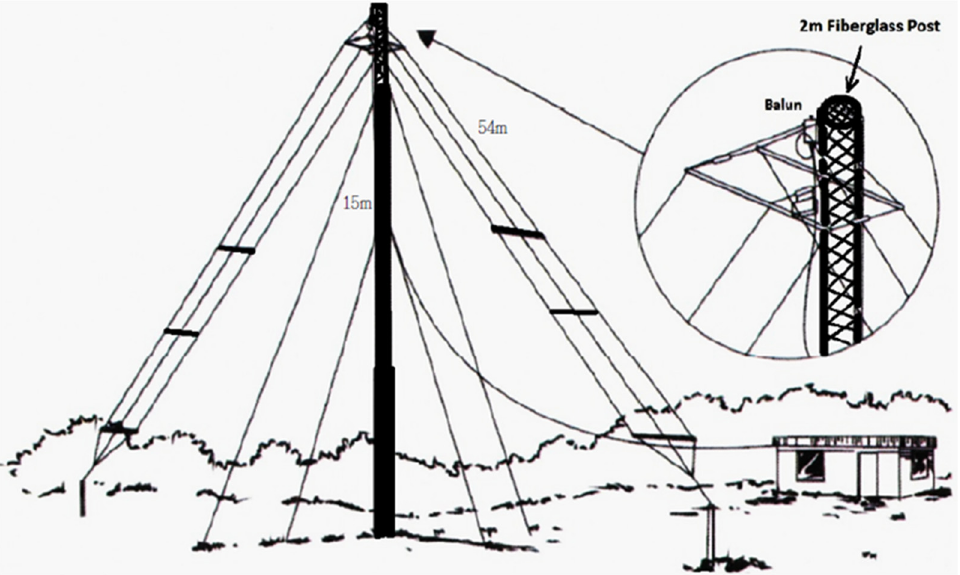
Figure 2. Drawing of the 54 m-long three-wire inverted-V dipole antenna of the Chung-Li ionosonde, in which the 2 m fiberglass post on top of the 13 m pole is highlighted.